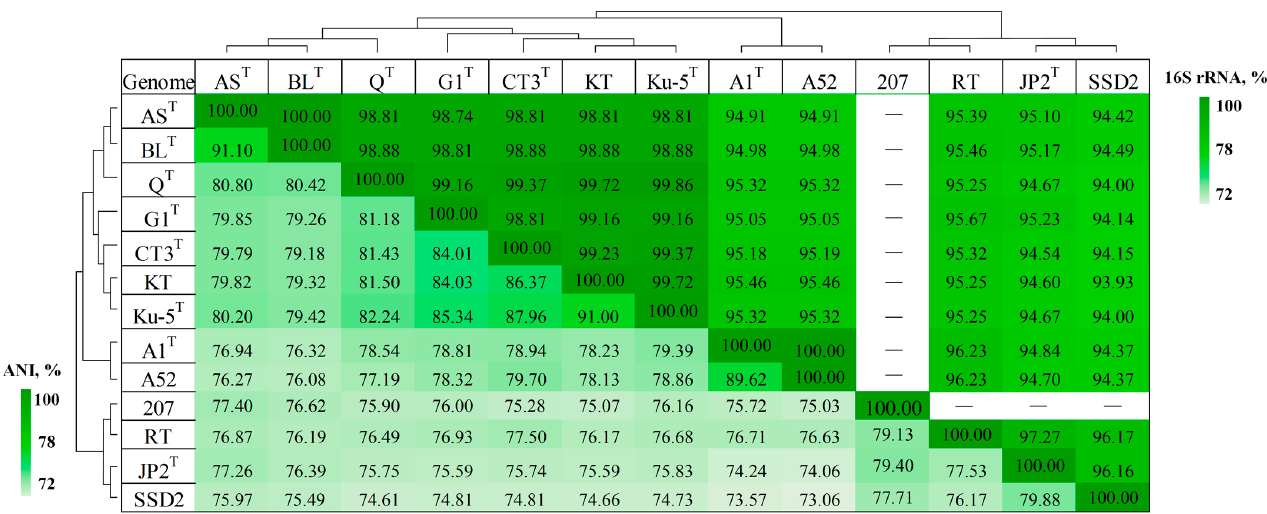
Figure 2. Heatmap of 16S rRNA gene sequence similarity and pairwise ANI values (%) for Thiothrix genomes. T. lacustris BL T , (GCF_000621325.1); Thiothrix litoralis AS T (GCF_017901135.1); ‘ Thiothrix subterranea’ Ku-5 T (GCF_016772315.1); ‘ Ca. Thiothrix sulfatifontis ’ KT (GCA_022828425.1); T. cald-